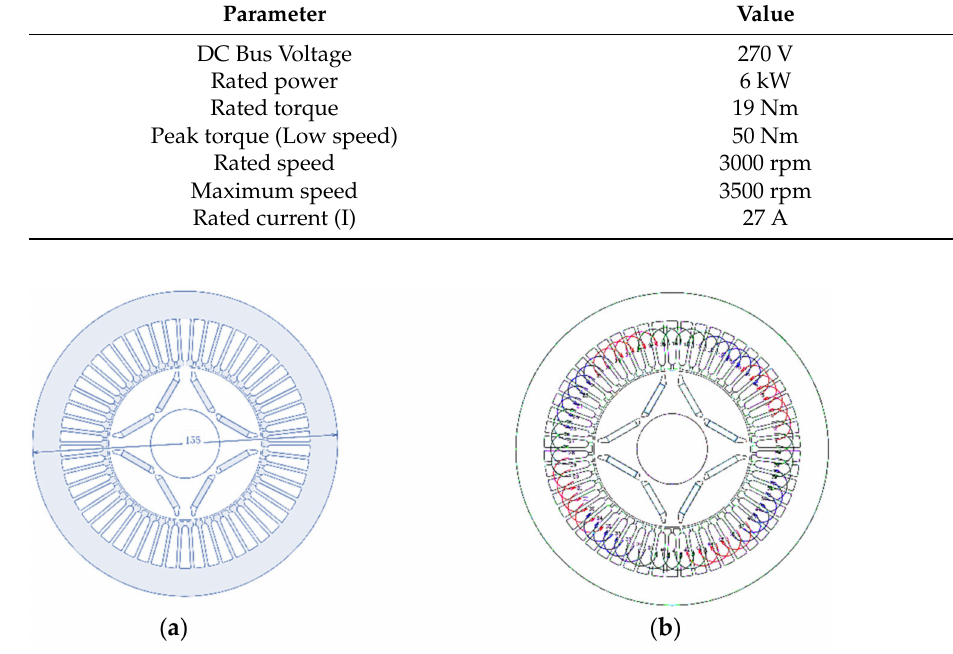
Figure 2. ( a ) Motor shape; ( b ) Winding